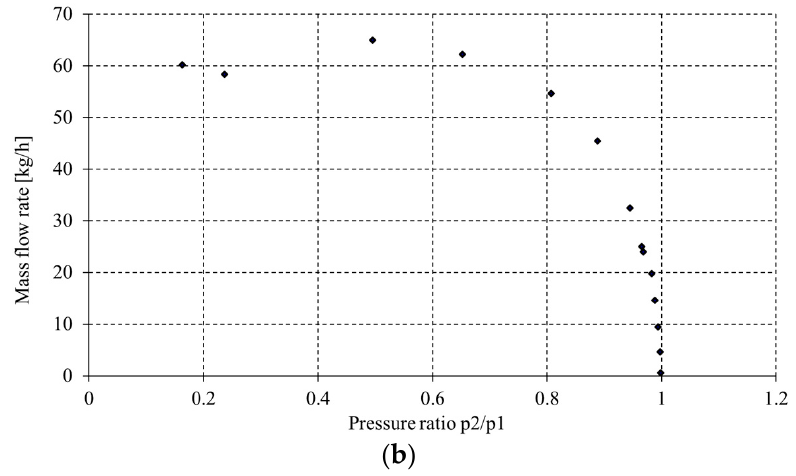
Figure 12. Dependence of the mass flow rate on the pressure ratio for the conduit: ( a ) 8 × 6 × 5, ( b ) 8 × 6 × 15.